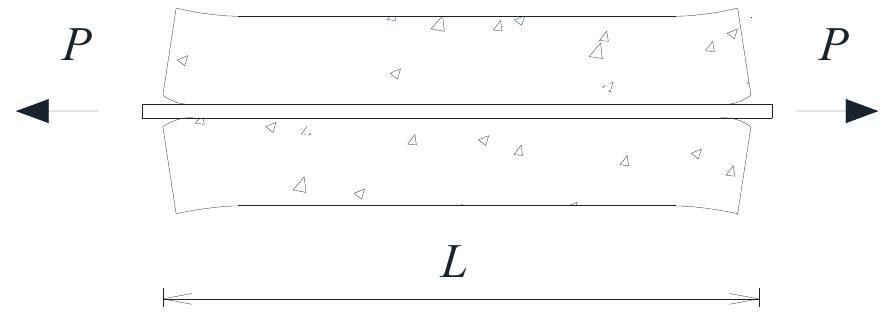
Figure 1. RC tensile